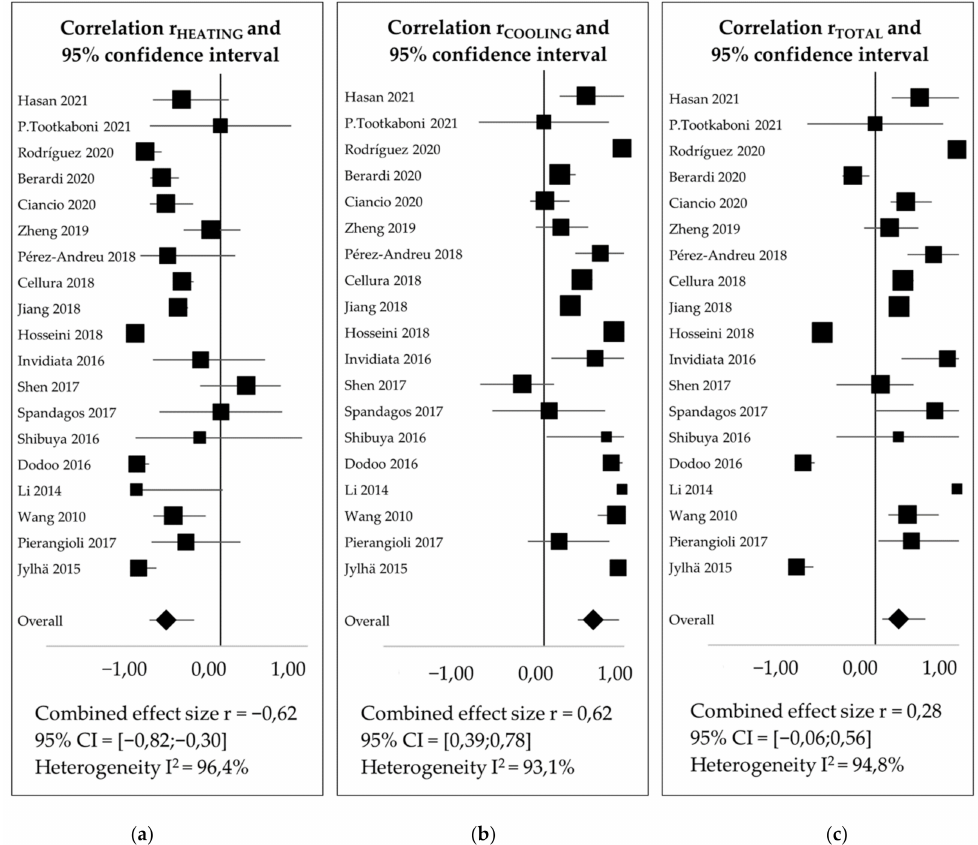
Figure 4. Forest plot obtained from the meta-analysis conducted on: ( a ) heating consumption variation, ( b ) cooling consumption variation, ( c ) total consumption